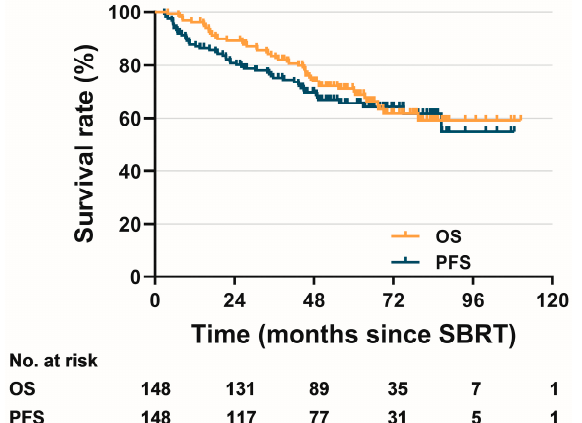
Figure 1. Kaplan–Meier curves for overall survival and progression-free survival of the entire cohort. Based on ROC analysis, optimal cut-off values of dNLR, MLR, PMR, albumin, LDH and CRP were 1.4, 0.3, 128, 43, 240 and 2.9, respectively (Figure S2). On univariate cox regres- sion analysis, we found a statistically significant association of pre-treatment dNLR ≥ 1.4